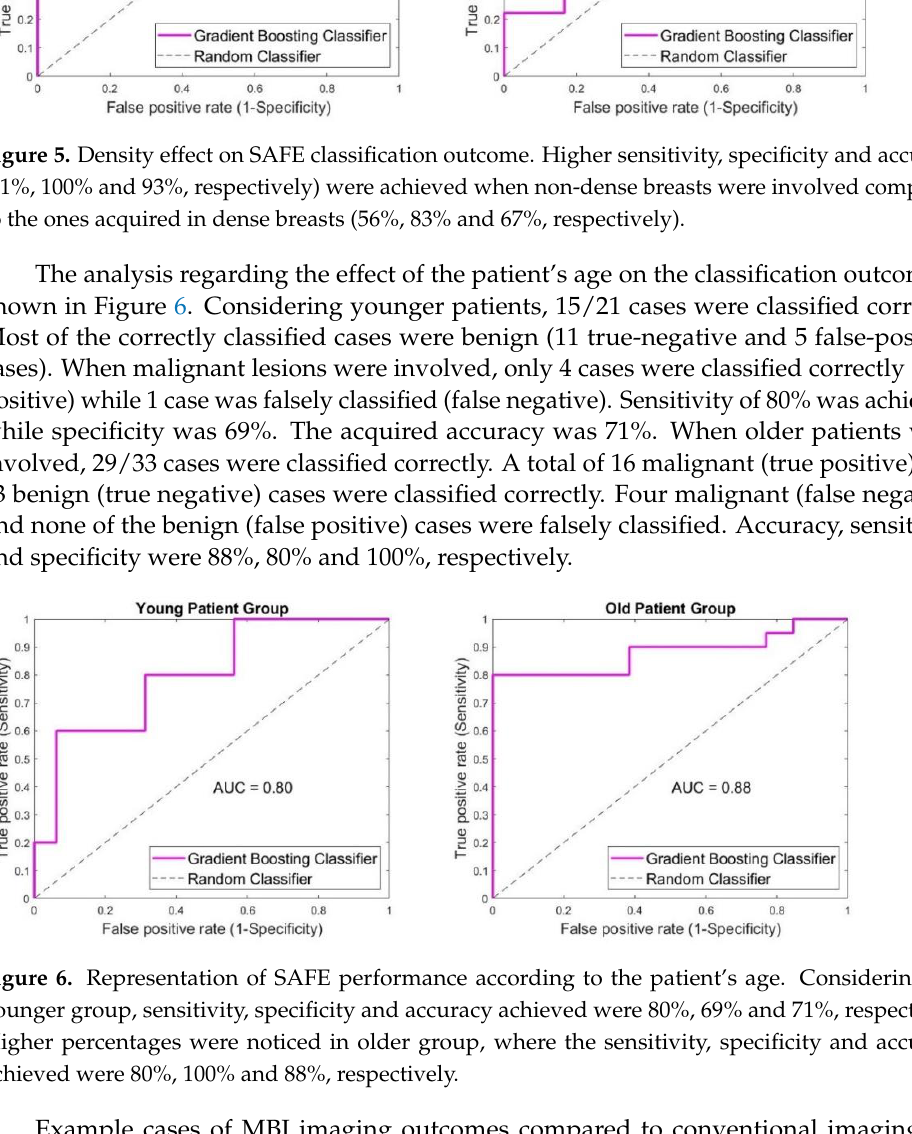
Figure 6. Representation of SAFE performance according to the patient’s age. Considering the younger group, sensitivity, specificity and accuracy achieved were 80%, 69% and 71%, respectively. Higher percentages were noticed in older group, where the sensitivity, specificity and accuracy achieved were 80%, 100% and 88%, respectively.